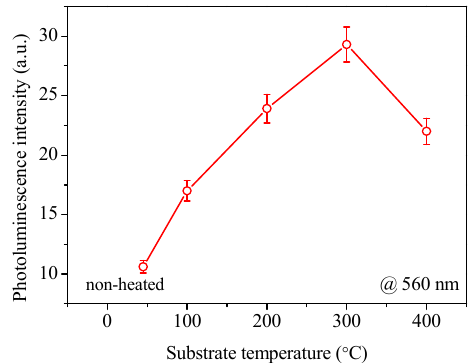
Figure 13. Dependence of photoluminescence intensity (around 560 nm) of AlN:Er films on the substrate temperature during film deposition.